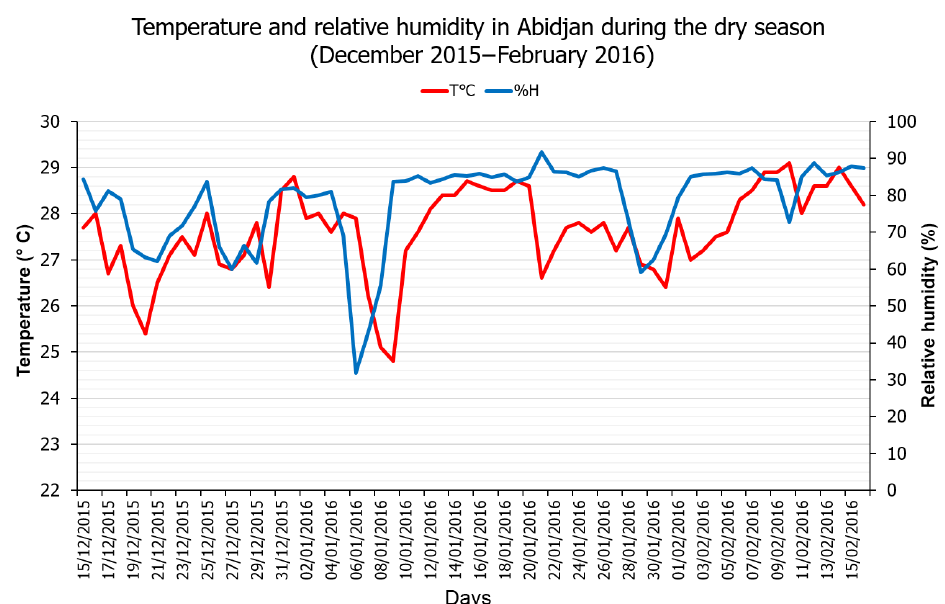
Figure 3. Temperature and relative humidity measured by ASECNA in Abidjan during the dry season (15 December 2015–16 Febru- ary 2016).